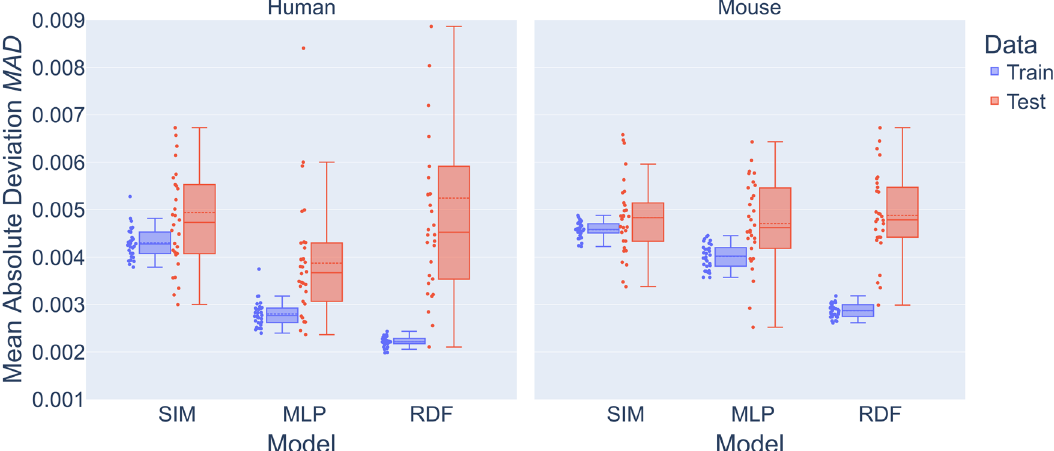
Fig. 5 Comparison of SIM performance with MLP and RDF. Mean absolute deviation (MAD) of the surrogate infection model (SIM) with a multilayer perceptron (MLP) and a random decision forest (RDF) via 5 times 6-fold cross-validation with train (blue) and test (red) data. Data points represent the distribution. Boxes represent the top and bottom quartiles of the distribution and whiskers are extended to 1.5 times the interquartile range. Horizontal line represents the median and dashed horizontal line the mean of the distribution.